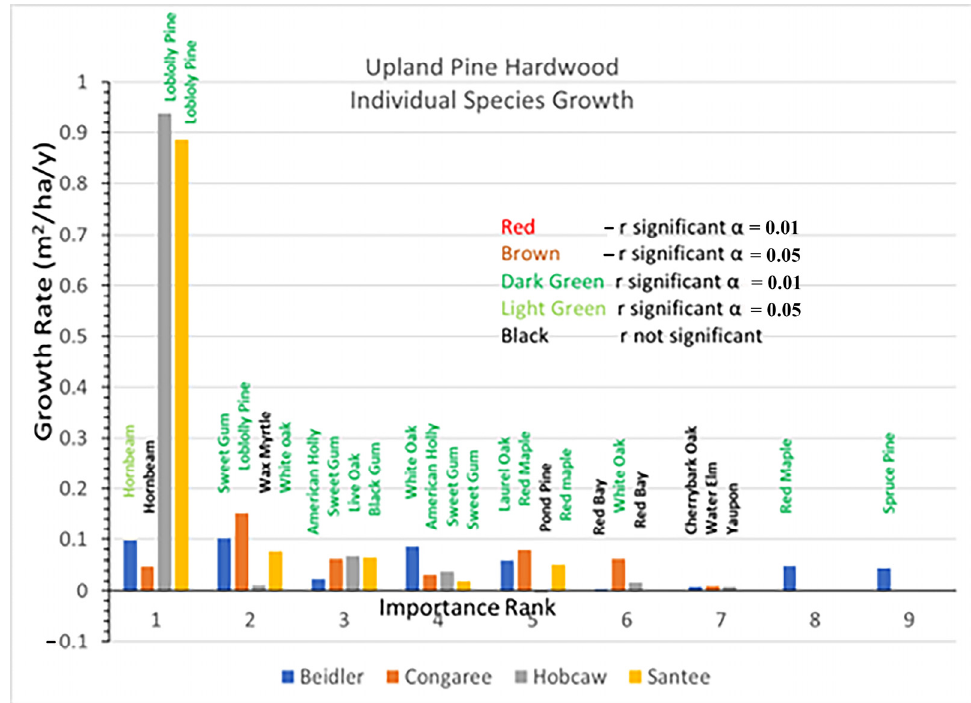
Figure 10. Distribution of basal area growth of species by importance factor (1 means the most important, while 9 means the least important) for each study site of the upland pine-hardwood vegetation type.